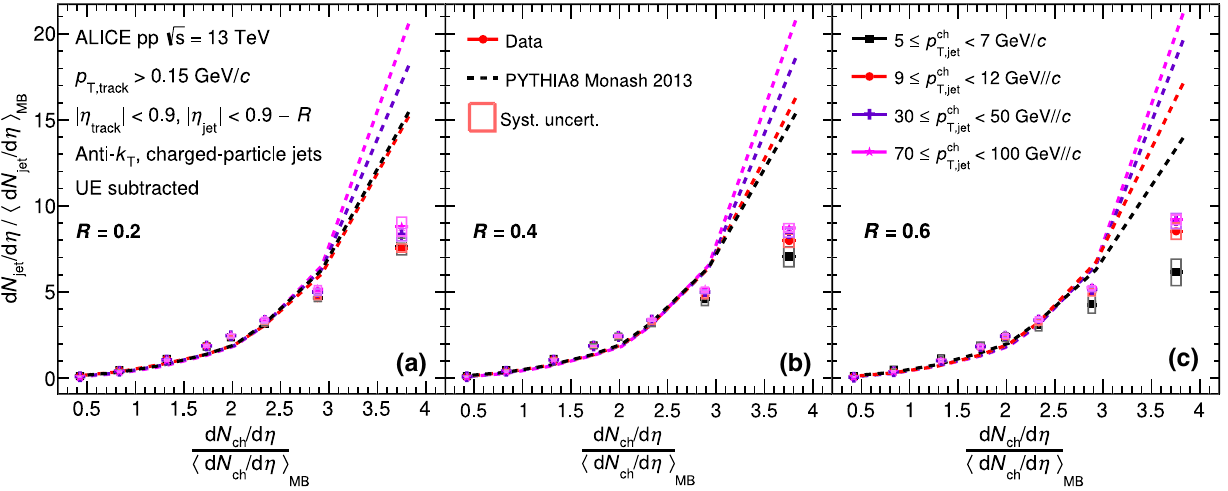
Fig. 21 Comparison of self-normalised jet yields as a function of given jet radii: R = 0 . 2 (a) , R = 0 . 4 (b) , R = 0 . 6 (c) between data andPYTHIA8predictions.Thecharged-particlemultiplicitiesaretaken the self-normalised charged-particle multiplicity in four selected jet < 7 GeV / c , 9 ≤ p ch < 12 GeV / c , p T intervals (5 ≤ p ch fromRef.[66].Statisticalandsystematicuncertaintiesareshownasver- T , jet T , jet tical error bars and boxes around the data points, < 50 GeV / c , and 70 ≤ p ch < 100 GeV / c ) for a 30 ≤ p ch T , jet T , jet